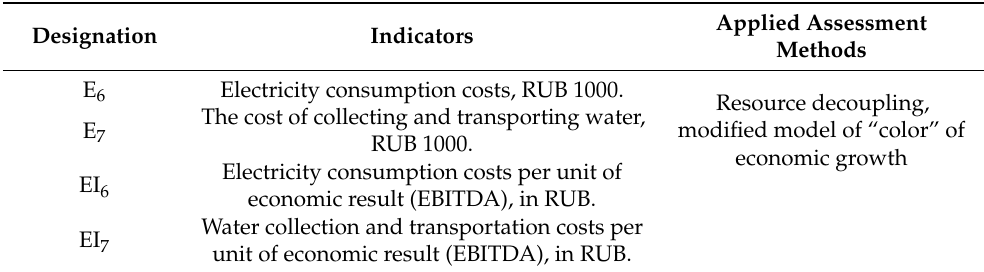
Table 5. Indicators of eco-intensity of the project for the introduction of a new oil production